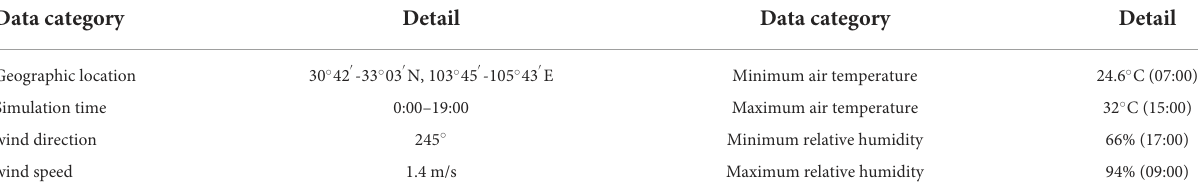
TABLE 3 Weather data adopted to simulate the ENVI-met model.